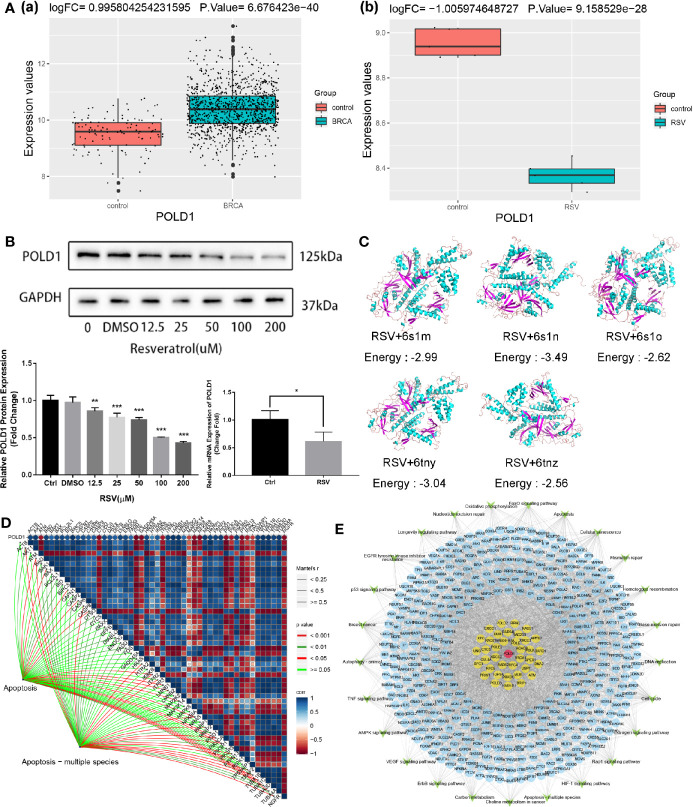
Comprehensive regulatory network for resveratrol in treating MDA-MB-231 cells. (A) (a) POLD1 expression in BRCA samples of TCGA database. (b) POLD1 expression in MDA-MB-231 cells samples after resveratrol treatment. (B) Protein expression of POLD1 after treatment with different concentrations of resveratrol (*P=0.043, **P=0.004, ***P<0.001). (C) Combined prediction model of resveratrol and POLD1 domain. (D) POLD1-differential apoptotic pathway gene-apoptotic pathway correlation pathway map. (E) Comprehensive regulatory network diagram. Red represents POLD1, yellow represents genes that interact with POLD1, blue represents genes that are affected by other resveratrol treatments for TNBC, and green represents pathways.